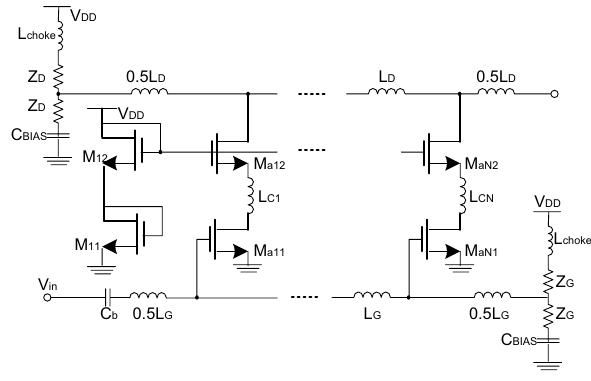
Figure 1. Schematic of the N-stage LNA 27 .